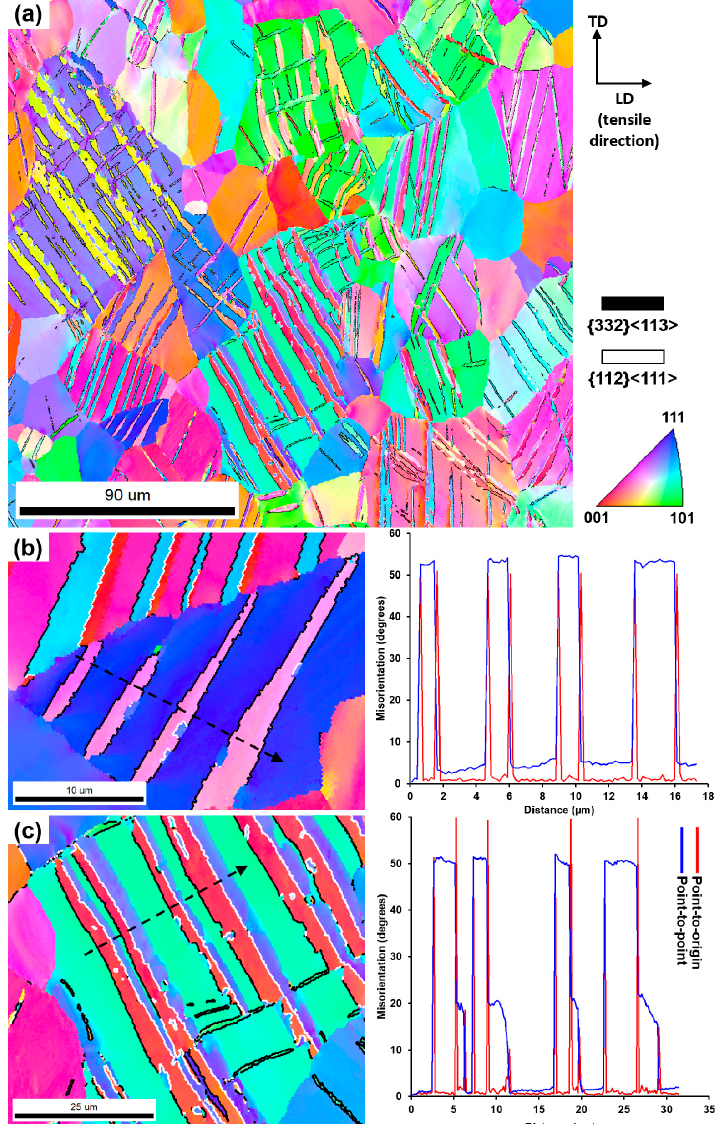
Figure 8. IPF map of the deformed Ti-14Nb-2Mo alloy ( a ) and selected grains at higher magnification ( b , c ) with the corresponding misorientation profile. The {332} <113> and {112} <111> twins boundaries are indicated by the black and white lines, respectively.